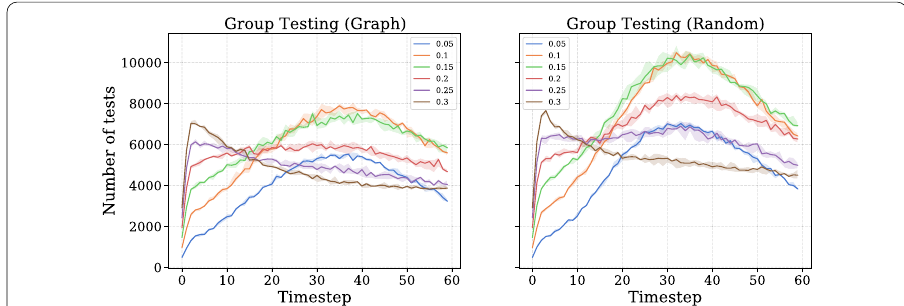
Fig. 9 Number of tests over time for group testing strategies at varying levels of testing, where δ =